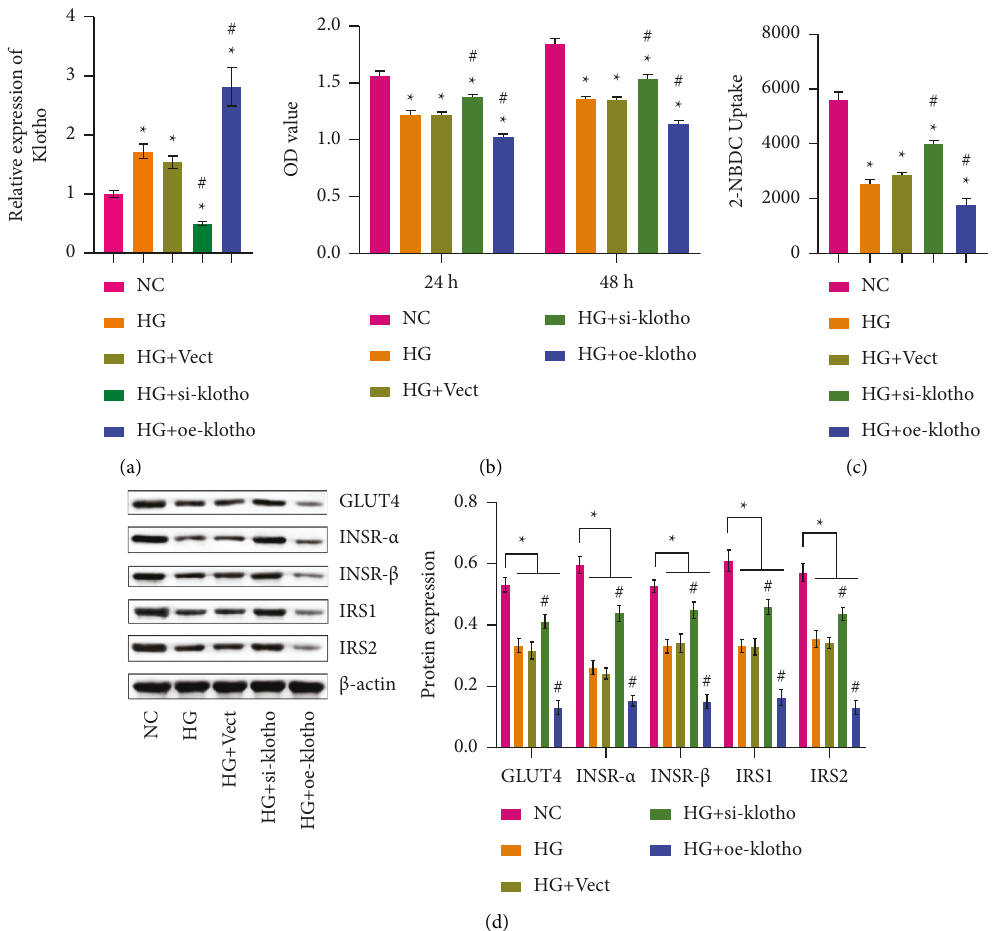
Figure 3: Klotho affected insulin sensitivity. (a). RT-qPCR of klotho levels. (b) CCK-8 detection was used to detect cell viability. (c) The cells were subjected to a glucose uptake assay. (d) Western blot of GLUT4, INSR- α , INSR- β , IRS1, and IRS2 protein levels. ∗ p < 0 . 05 compared with the NC group. # p < 0 . 05 compared with the HG